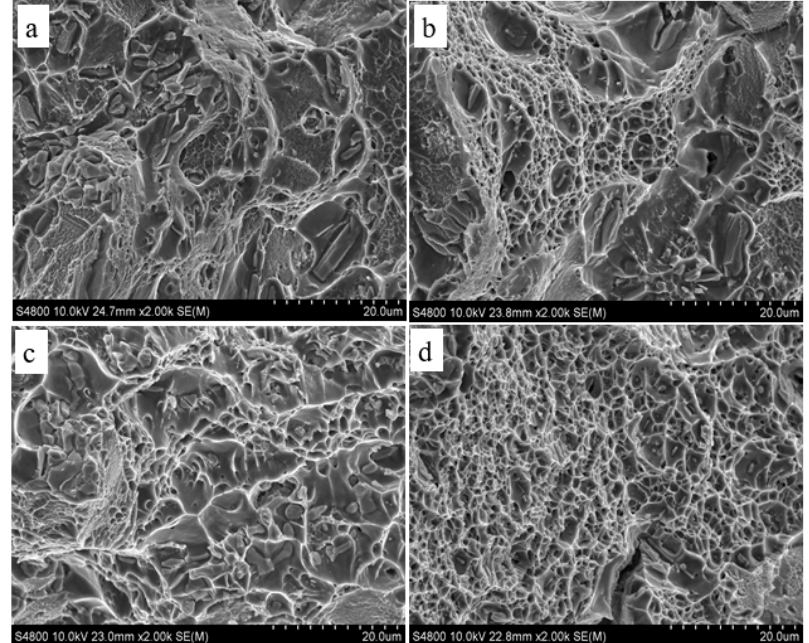
Figure 8. SEM images showing fracture morphology of single-wire and double-wire walls: ( a ) longitudinal of single-wire; ( b ) transverse of single-wire; ( c ) longitudinal of double-wire; and ( d ) transverse of double-wire.